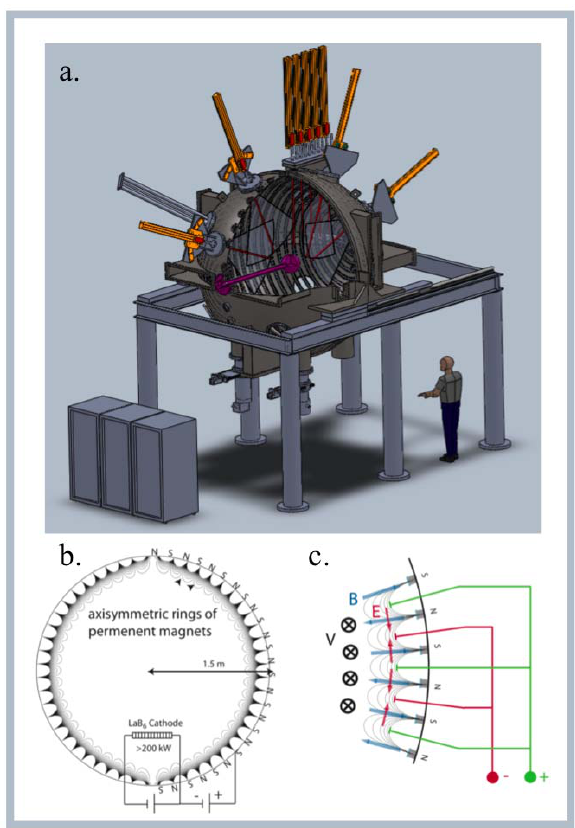
Figure 12. a. The Madison Plasma Dynamo Experiment (MPDX) under construction at the UW-Madison. b. The flux contours for the MPDX; the ring cusp magnetic field is generated by axisymmetric rows of 1.2 Tesla dipole magnets with alternating polarity. c. Alternating positive and negative electrostatic bias is applied to electrodes between cusp rings; the resulting torque from the plasma current crossed into the magnetic field causes the plasma to rotate about the symmetry axis and can be used for generating a variety of velocity